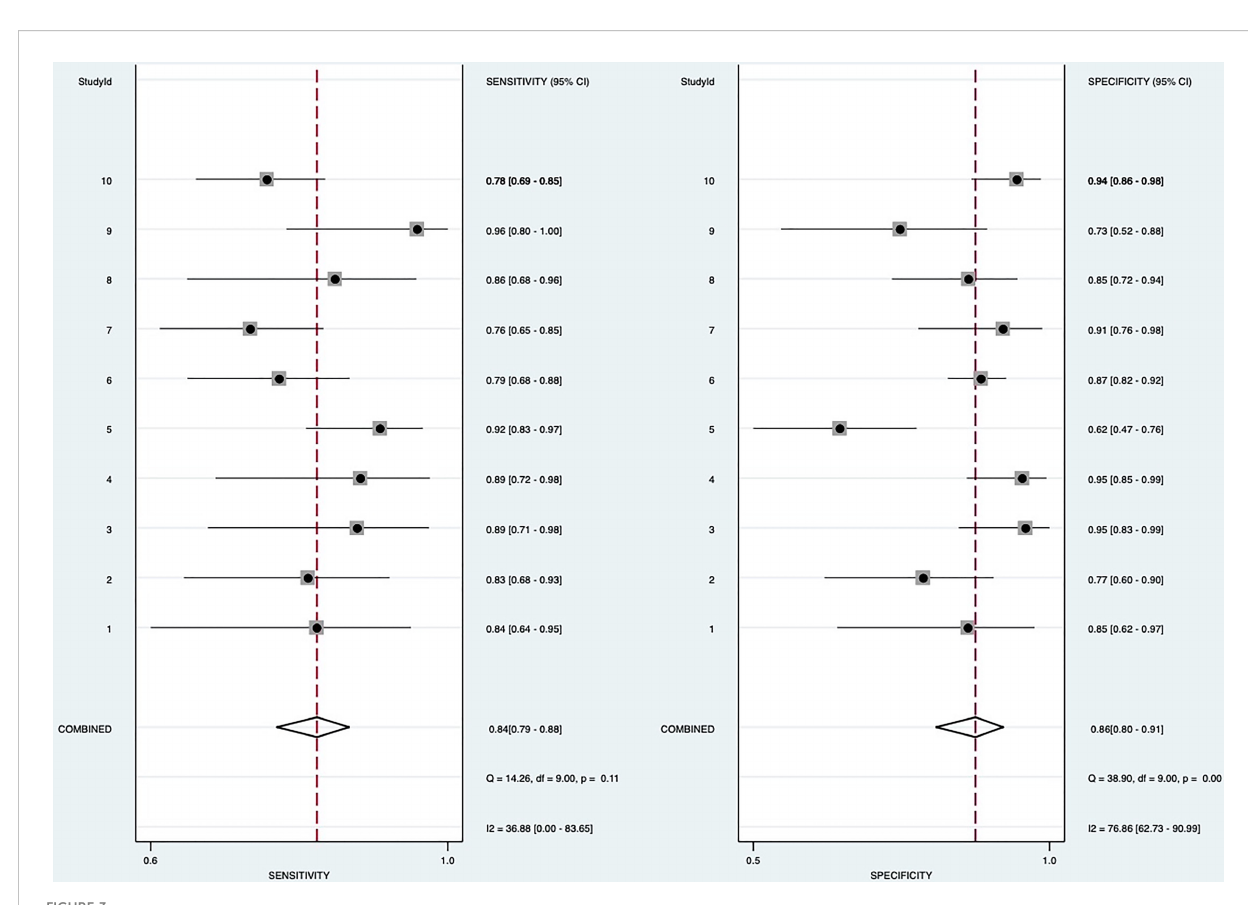
FIGURE 3 Forest plot for sensitivity and speci fi